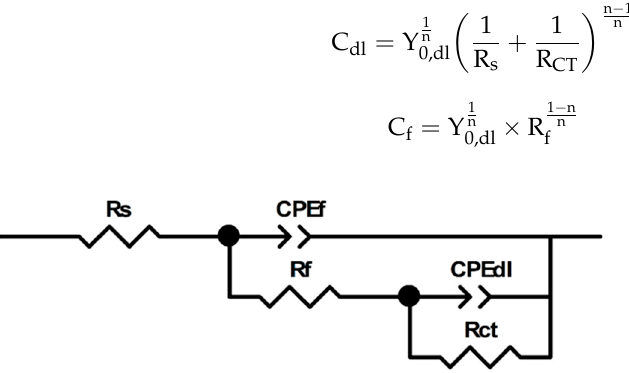
Figure 6. Equivalent circuit model used to fit the impedance data.